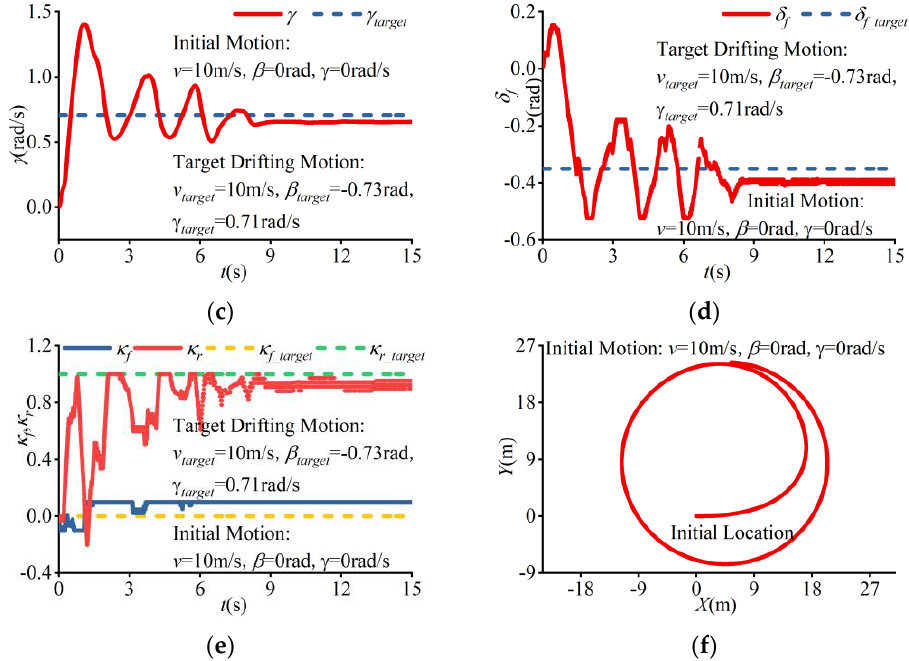
Figure 9. The simulation result with the initial motion as Group 3 in Table 3 to realize the target drifting motion as Group 2 in Table 2: ( a ) the variation curve of the velocity; ( b ) the variation cure of the sideslip angle; ( c ) the variation curve of the yaw rate; ( d ) the variation cure of the steering angle; ( e ) the variation curves of the TYDEX longitudinal slip ratios; ( f ) the position modification of the narrow tilting vehicle in the ground coordinates.